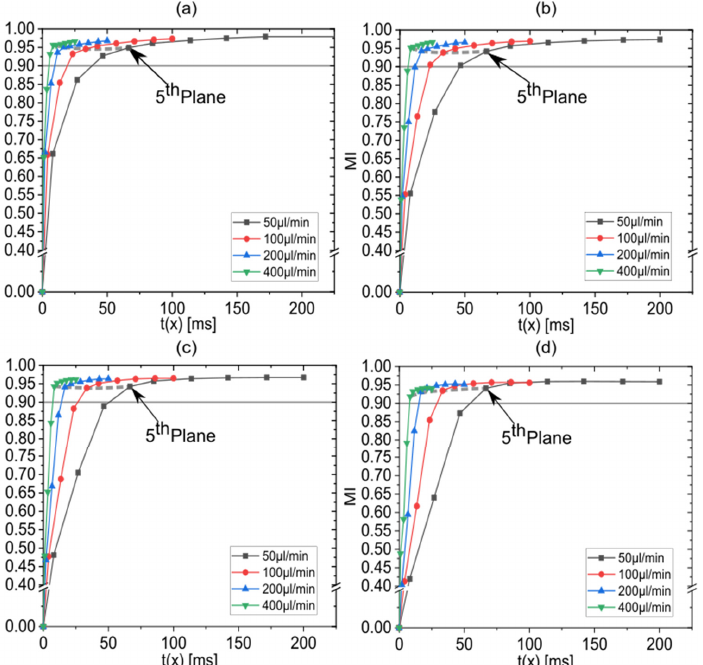
Figure 8. MI versus elapsed residence time for varied total flow rates of 50 μ L/min, 100 μ L/min, 200 μ L/min and 400 μ L/min at flow rate ratios of ( a ) 5%, ( b ) 10%, ( c ) 15% and ( d ) 20%. Above the straight gray horizontal lines, practically complete mixing is achieved. Data points corresponding to the fifth plane are connected with dotted gray lines.